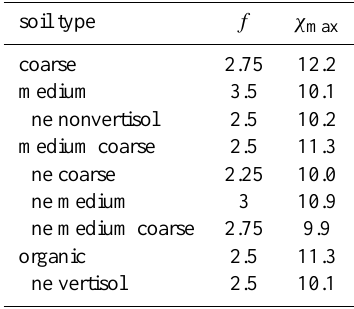
Table 2. Topmodel parameters f and χ max for LPJ soil